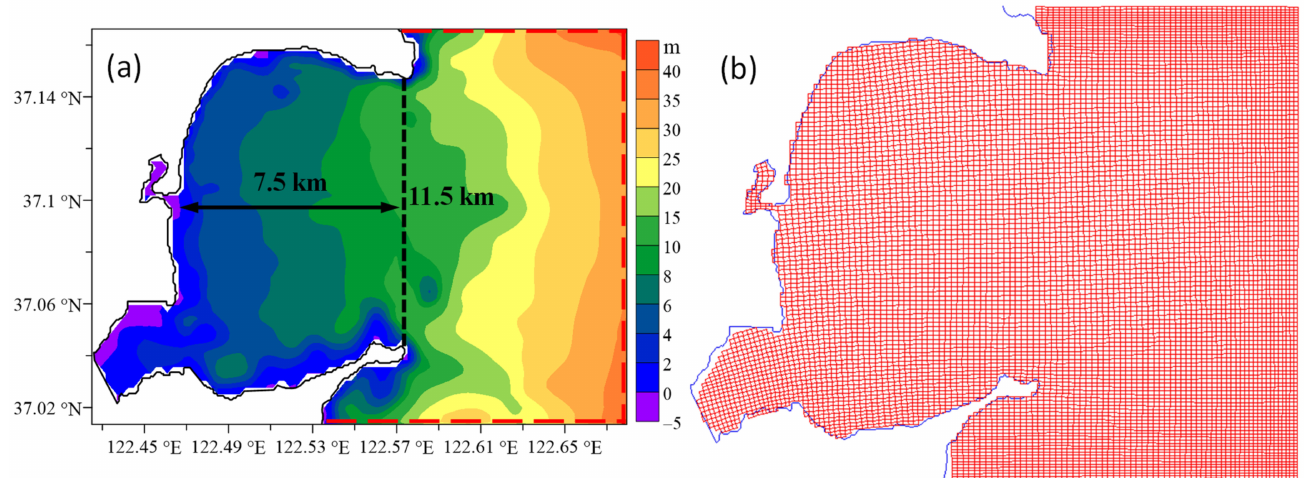
Figure 2. The ( a ) topography and ( b ) model grids of Sungo Bay. The area west of the black dashed line is the inner bay, where the water-exchange ability was computed. Red dashed lines are open